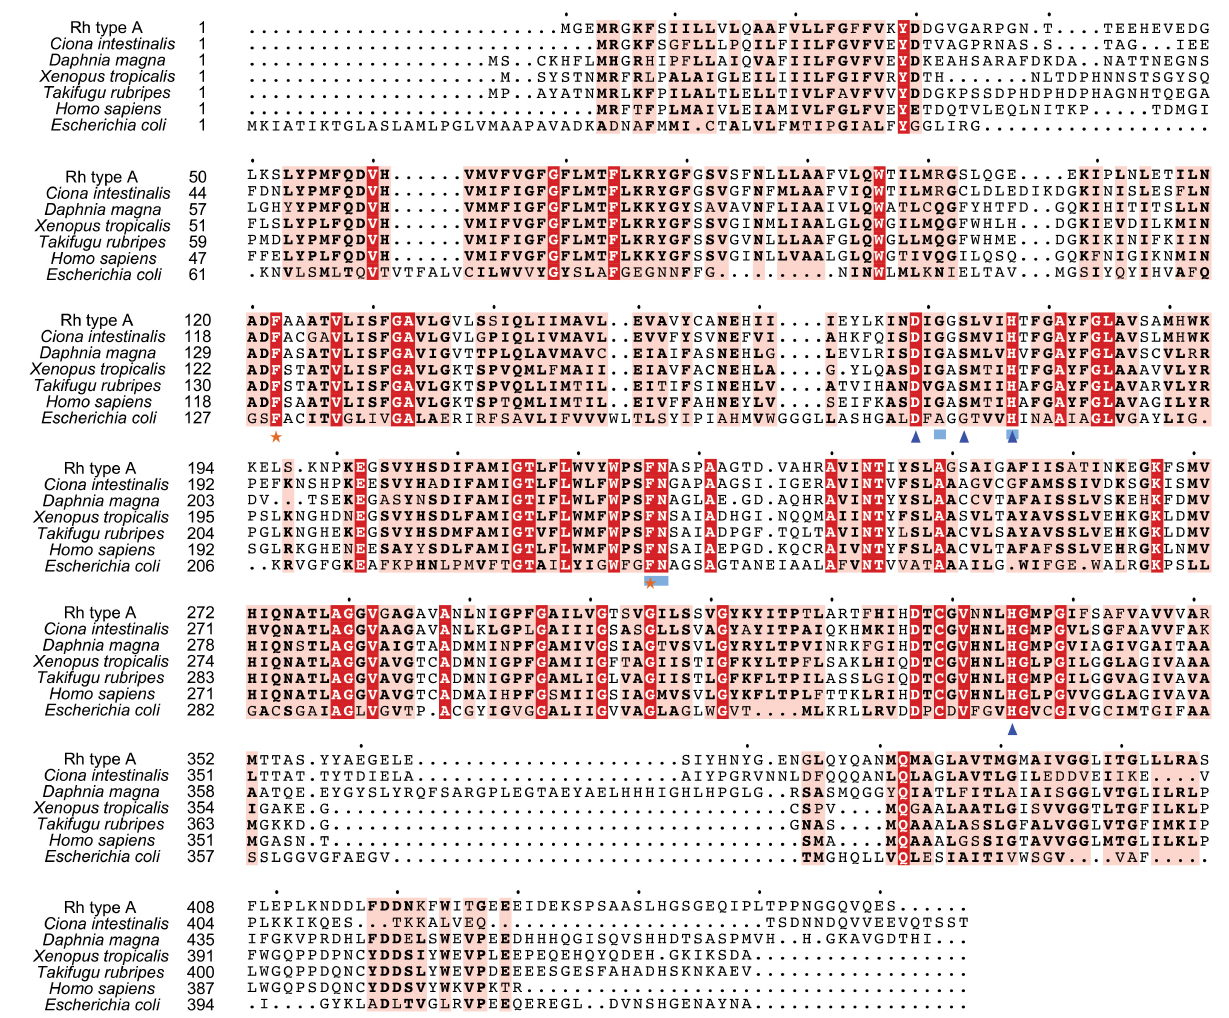
FIGURE 3 | Multiple amino acid alignment of deduced Rh type A of M. manhattensis with E. coli AmtB and corresponding sequences of selected species. Identical amino acid residues are in bold white and filled with red. Strongly similar amino acid residues are in bold black and filled with light red. Phenylalanine gates of the ammonia channel are indicated by black stars. Residues involved in NH 4 + recruitment are indicated by light blue strokes. Residues involved in deprotonation are indicated by blue